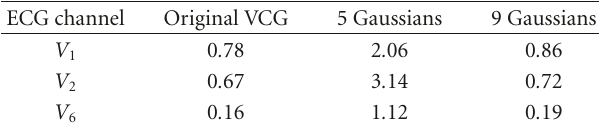
Table 3: The percentage of MSE in the ECGs reconstructed by Dower transformation from the original VCG and from the syn- thetic VCG using five and nine Gaussian